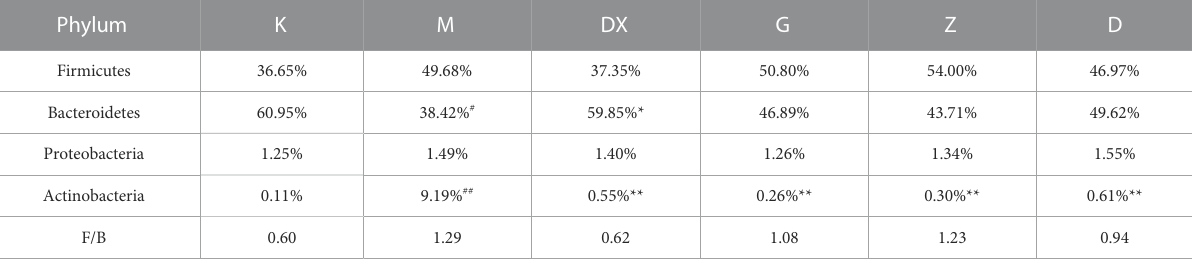
TABLE 2 Effects of R-S on species composition of the intestinal micro fl ora of insomniac rats in phylum. Phylum K M DX G Z D Firmicutes 36.65% 49.68% 37.35% Bacteroidetes 60.95%